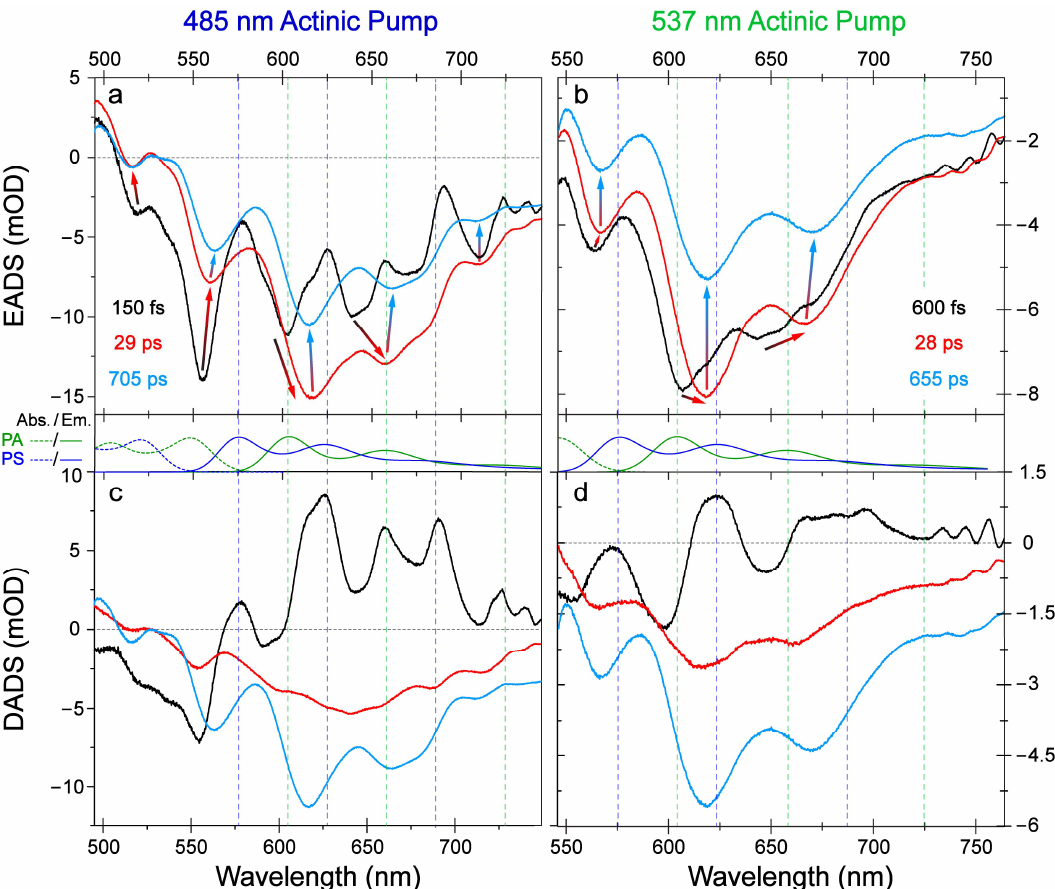
Figure 3. Global analysis of the fs-TA spectra of Draconin Red in DCM solvent following two representative excitation wavelengths. The evolution-associated difference spectra (EADS) after ( a ) 485 nm and ( b ) 537 nm excitations expose notable differences on the basis of a kinetic scheme: black → red → cyan traces, with the associated lifetimes listed in the insets. The color-coded arrows depict the spectral peak evolution across the detection window. The decay-associated difference spectra (DADS) after ( c ) 485 nm and ( d ) 537 nm excitations provide further insights on the basis of a parallel model with identical lifetimes as EADS. Middle panels show the calculated absorption (dotted lines) and emission (solid lines) bands of the PA (green) and PS (blue) tautomers. Vertical dashed lines are color-coded to highlight the corresponding PS* and PA* emission peak locations across the visible spectral window. The zero-difference in milli-optical density (mOD) is denoted by the horizontal do(cid:308)ed line in each panel (except in panel b where all signals are negative).